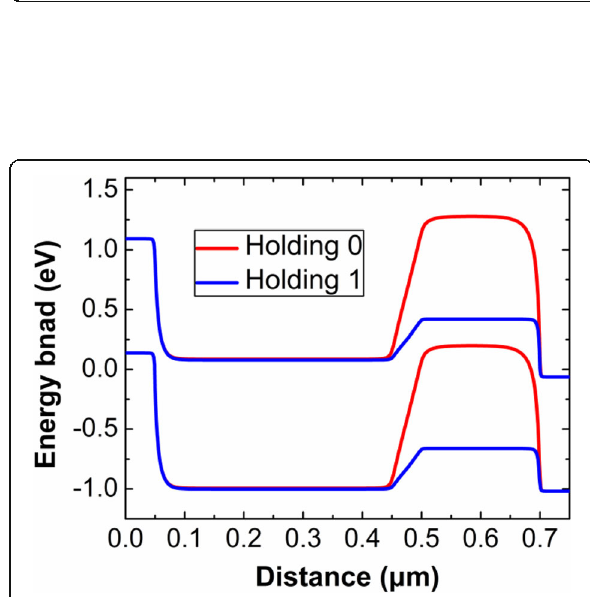
Fig. 6 Energy band diagram after a holding “ 1 ” and b holding “ 0 ” . a , b The energy band of the device after holding “ 1 ” and holding “ 0 ” , respectively. The energy band is extracted at the 3 nm below the gate